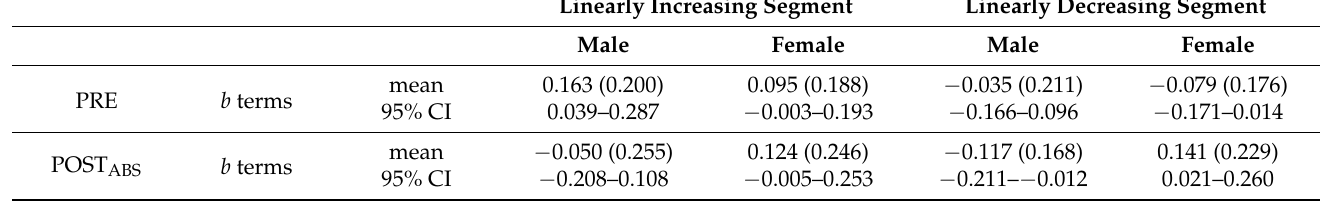
Table 1. Means, standard deviations (in parentheses), and 95% confidence interval (CI) ranges for the b terms calculated for the log-transformed mechanomyographic median power frequency–torque relationships during the pre-training (PRE) and post-training absolute (POST ABS ) torque levels for the males and females.